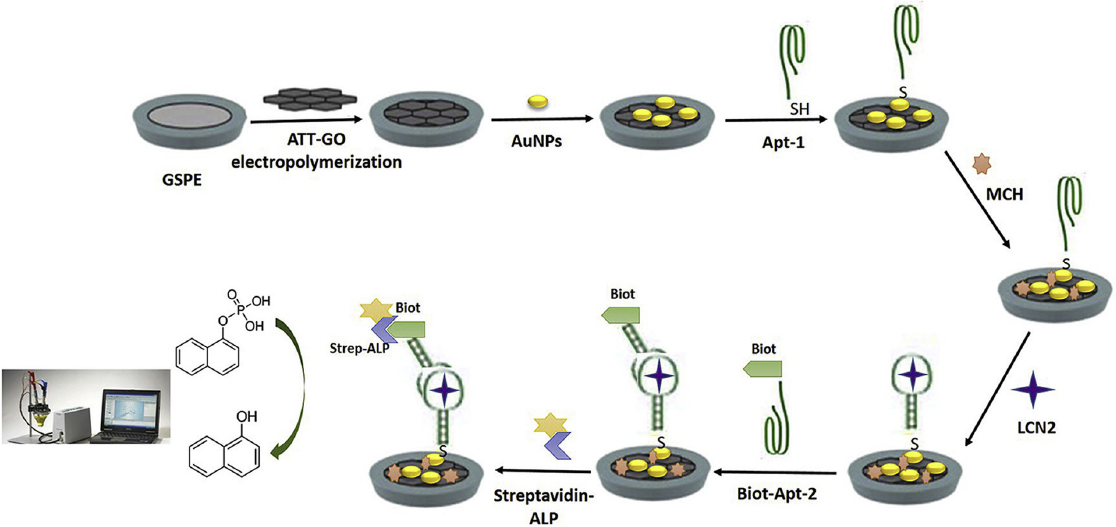
Figure 7. ELONA-type electrochemical aptasensor sensor for the detection of lipocalin-2 utilizing poly-3-amino-1,2,4-triazole-5-thiol/graphene oxide composite (ATT-GO). Adapted with permission from T ı ğ et al. [78]. Copyright © (2020), Elsevier.